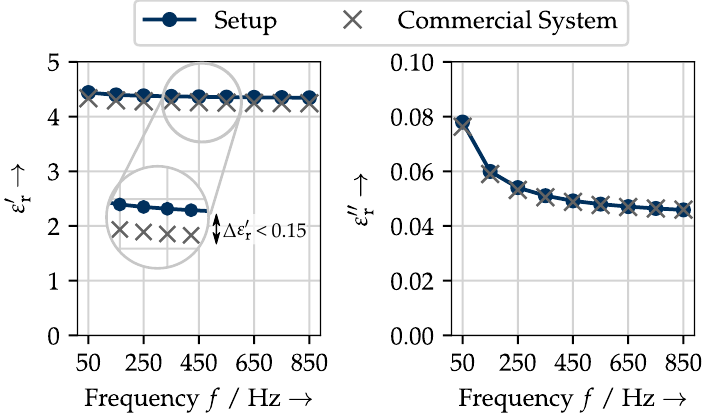
Figure 4. Comparison of measured permittivity values between a commercial loss tangent measure- ment system and the presented test setup on epoxy samples; no voltage distortion.